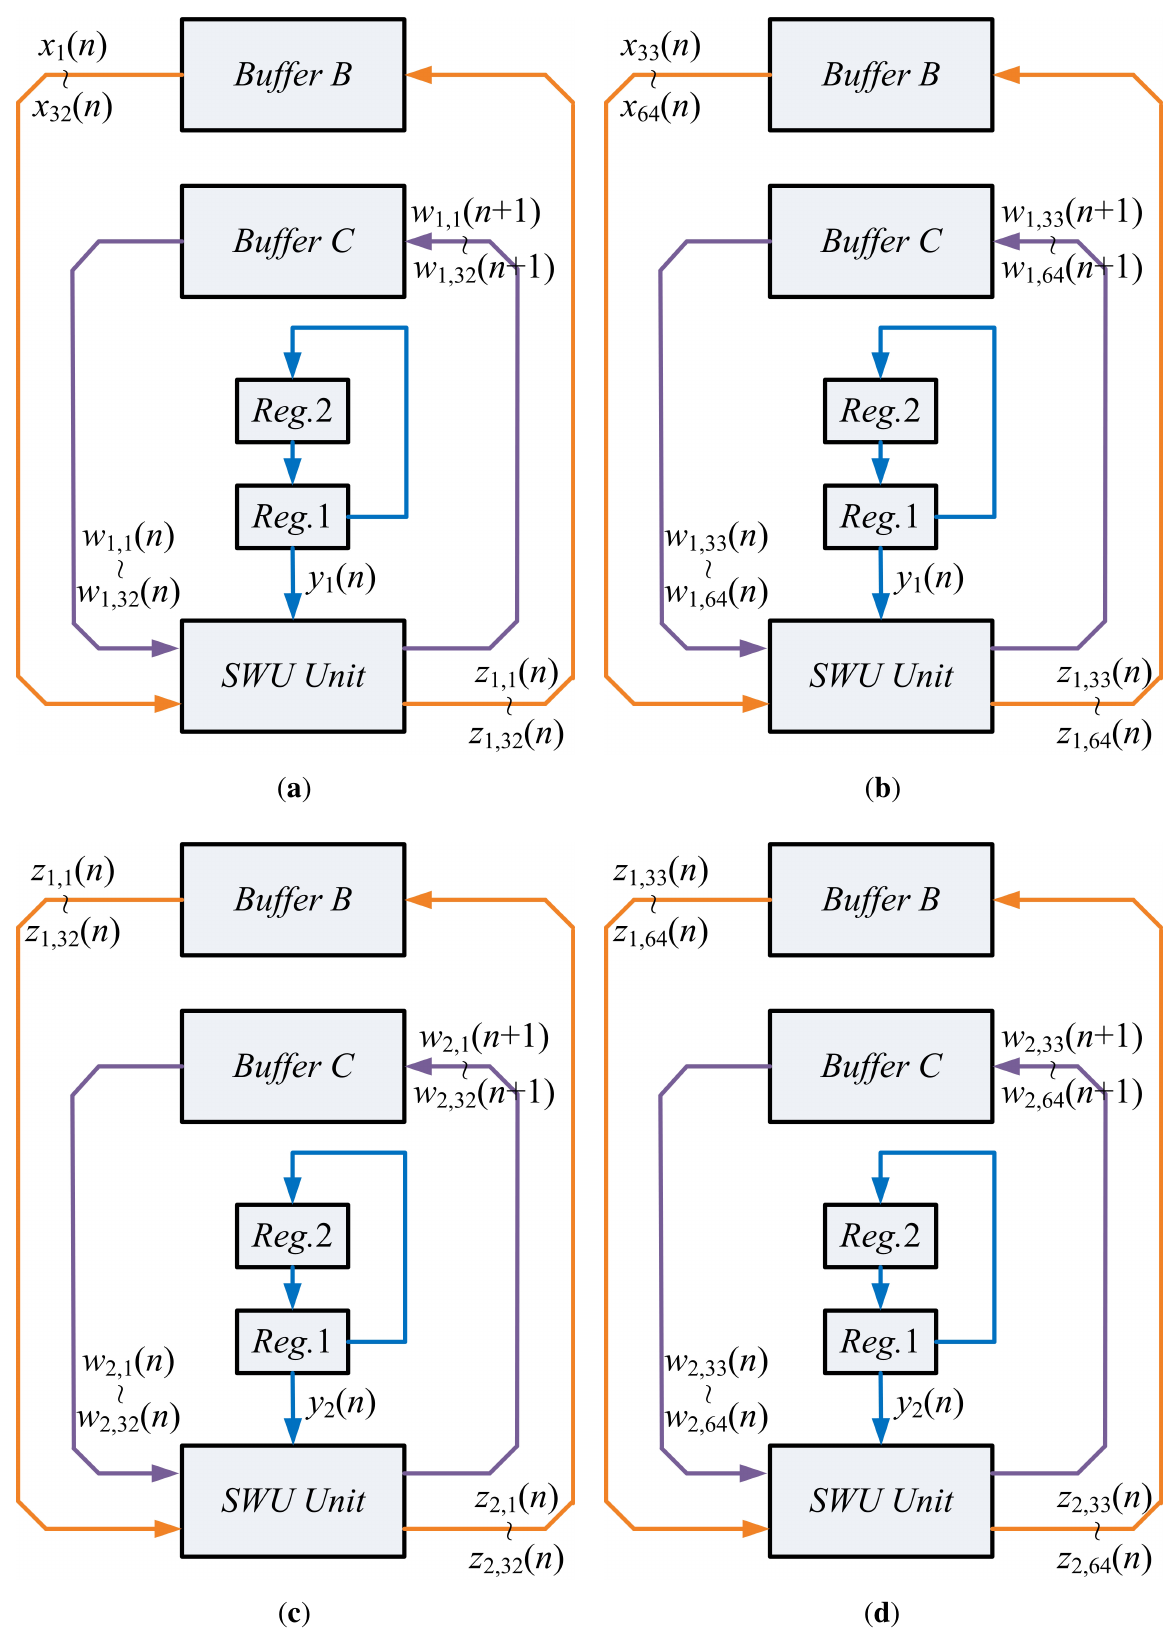
( n + 1) ; ( c ) first step of computing w 1 ( n + 1) 2